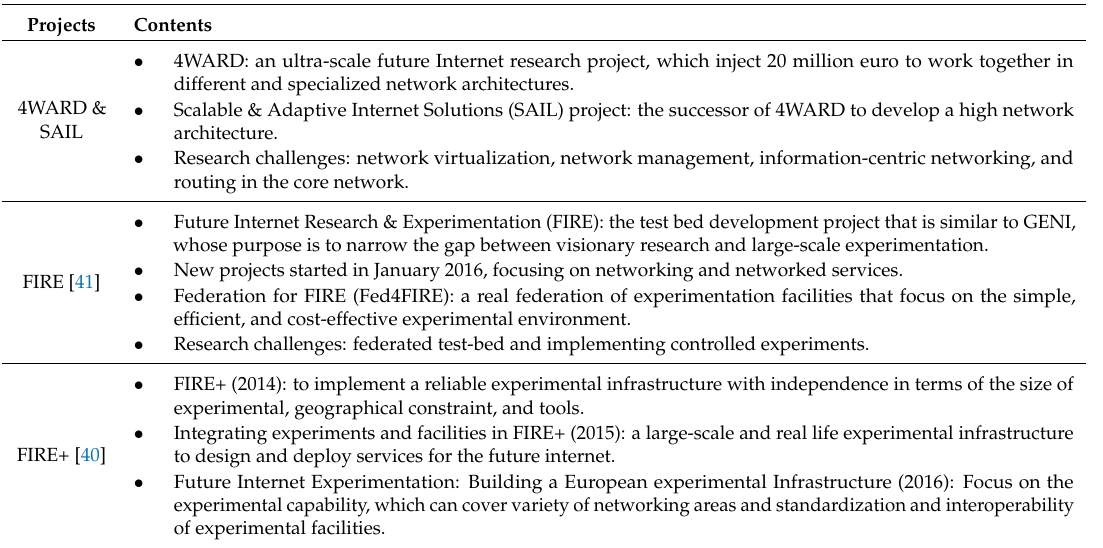
Table 1. The projects of the future network in the EU.